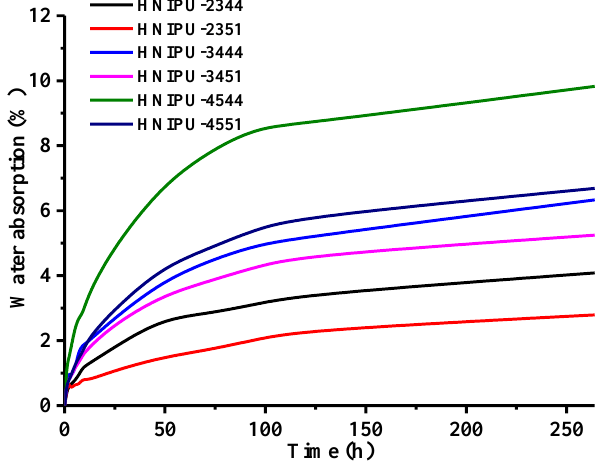
Figure 8. Water absorption behavior of different HNIPUs.